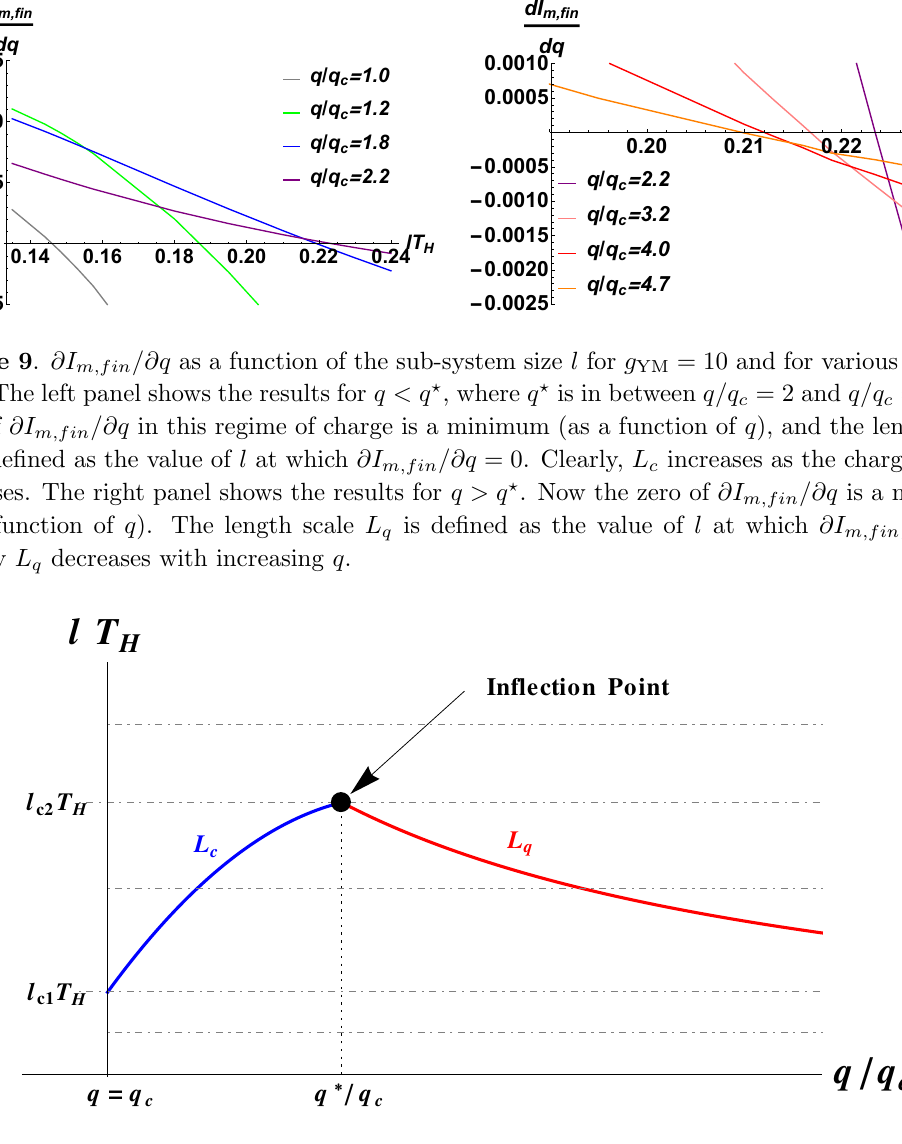
Figure 10 . Phase space ( lT H ; q=q c ). The two curves L c ( q=q c ) and L q ( q=q c ) meet at q = q ? . In the tent like region below these curves the derivative ( @I m;fin =@q ) l > 0, outside the tent this is